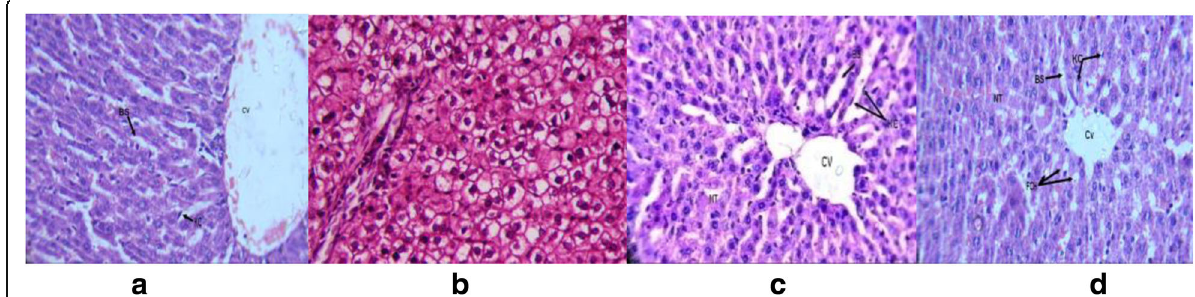
Fig. 3 Histopathological graphs showing a liver of normal rat (negative control) with normal blood sinusoids, normal histoarchitecture, and hepatic cords with normal appearance and distribution of Kuppfer cells (KC). b A photomicrograph of liver of diabetic rat showing Kupffer cells activation and cytoplasmic vacuolization of hepatocytes, dilatation of liver sinusoids, and some necrotic changes of liver tissue. c Liver of Diamicron-treated group showing moderate blood sinusoids (BS) with mild increased of Kupffer cells, mild necrotic changes, normal tissue histoarchitecture, and normal hepatic cords. d Liver of curcumin-treated group showing normal tissue histoarchitecture with mild dilatation of blood sinusoids, mild increase in number and distribution of Kuppfer cells, moderate fatty changes (FCH), and moderate necrotic changes (NT)